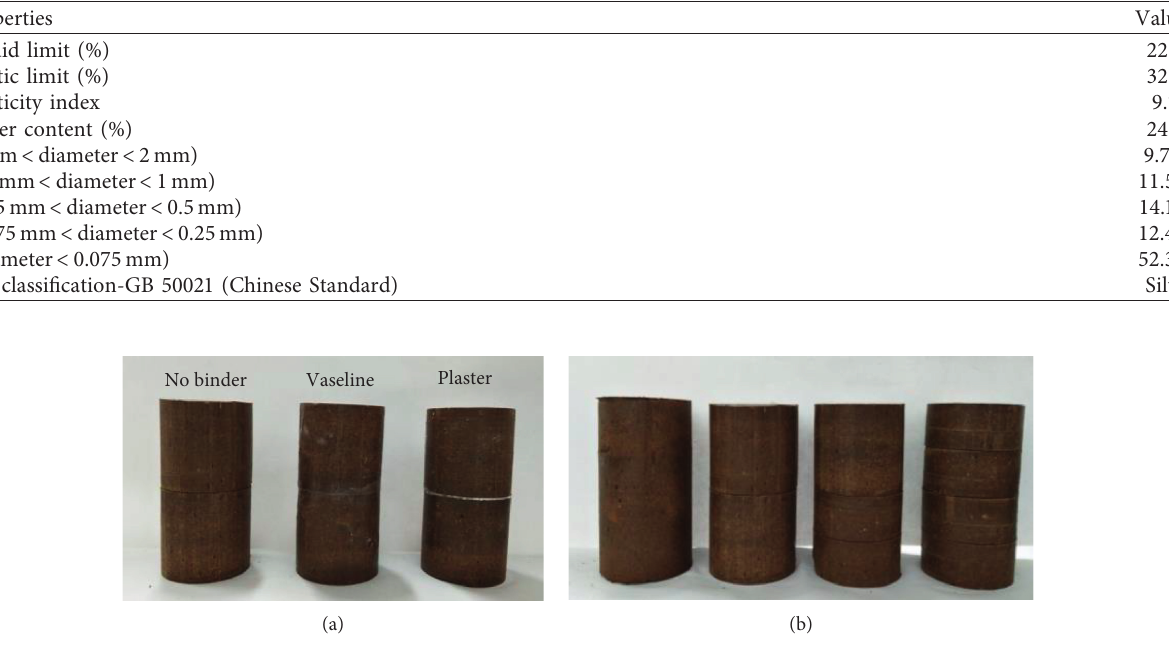
Figure 1: Frozen silty soil specimens for static tests. (a) With different binders. (b) With different prefabricated crack numbers.